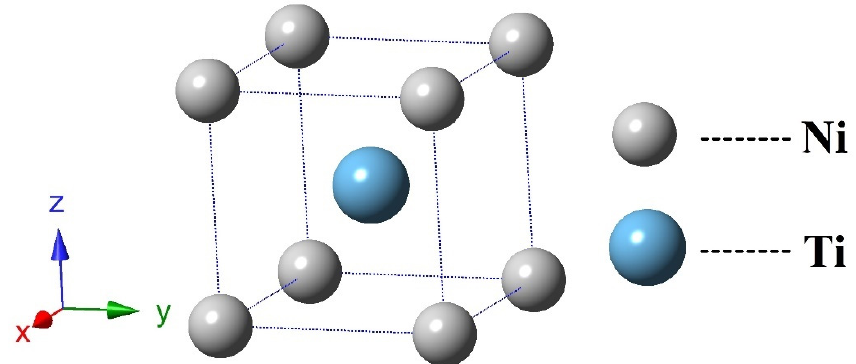
Figure 1. Cubic structure model of B2-phase NiTi shape-memory alloy (SMA).